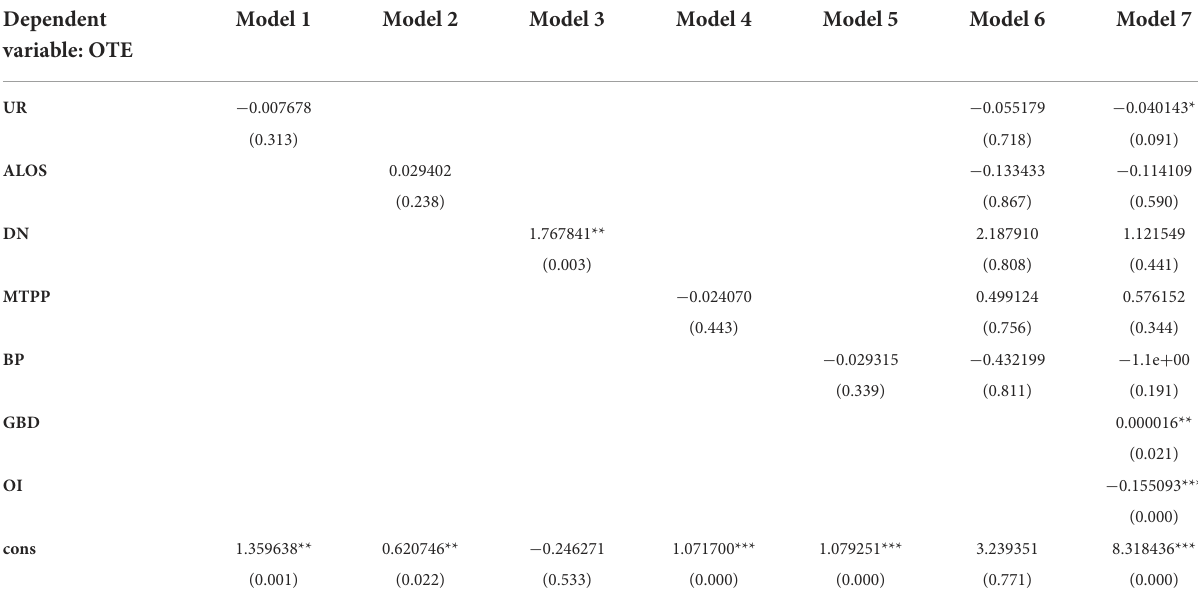
TABLE 6 Results of bootstrapping truncated regression for tertiary hospitals.